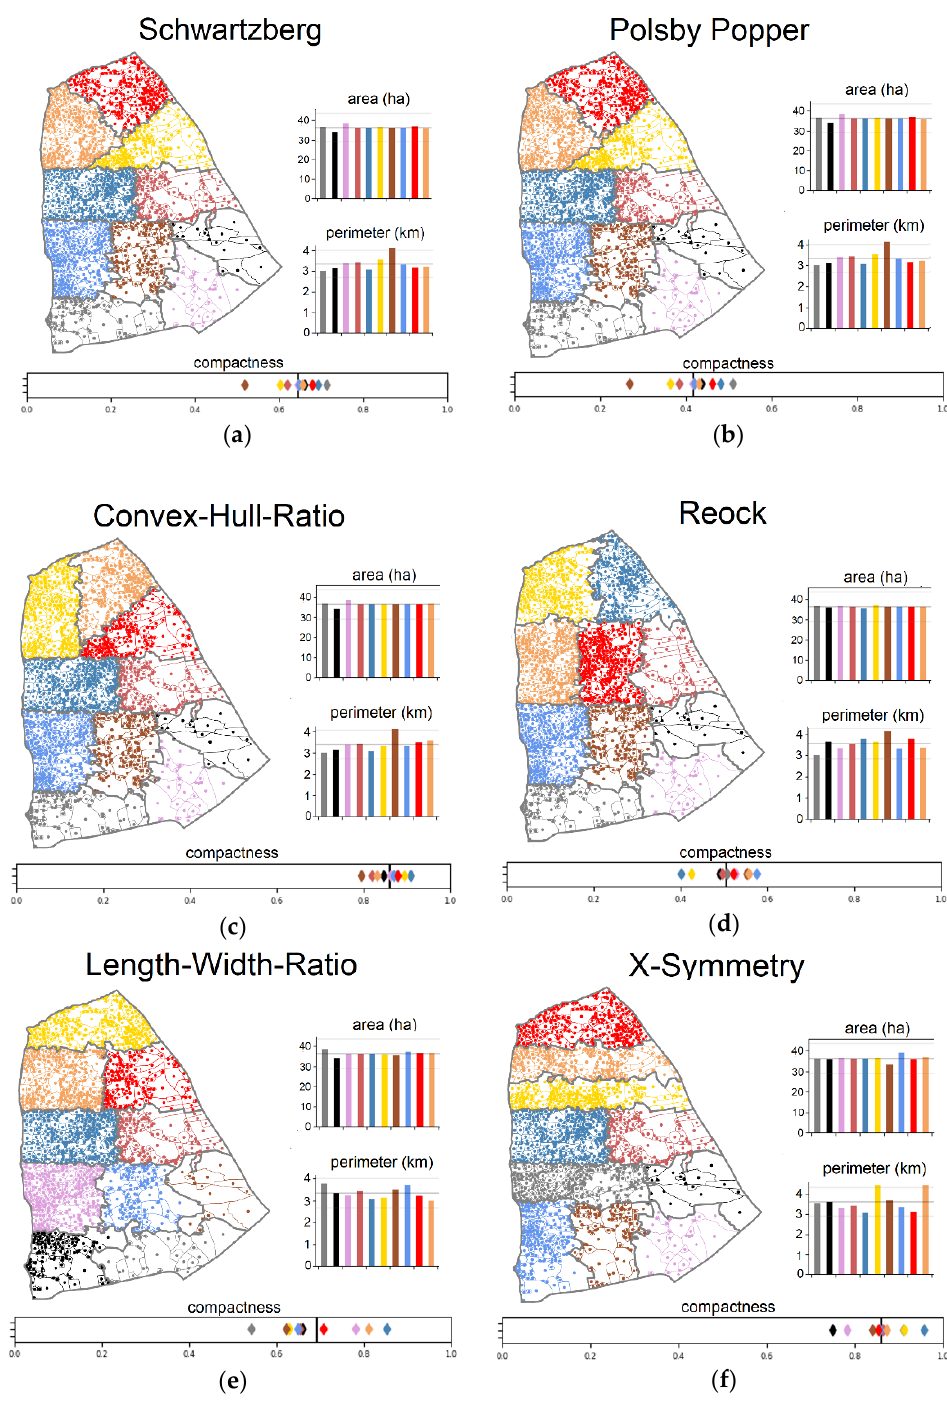
Figure 5. Results of area classification according to different compactness measures: Schwartzberg (a), Polsby Popper (b), Convex-Hull-Ration (c), Reock (d), Length-Width-Ratio (e), X-Symmetry (f).